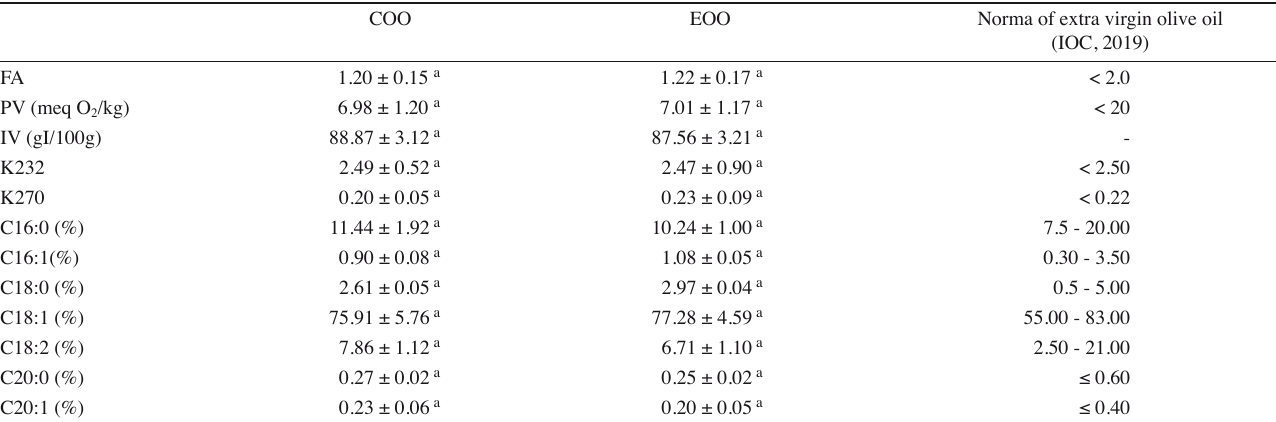
Tab. 1: Standard quality indices and fatty acid composition of studied olive oils.